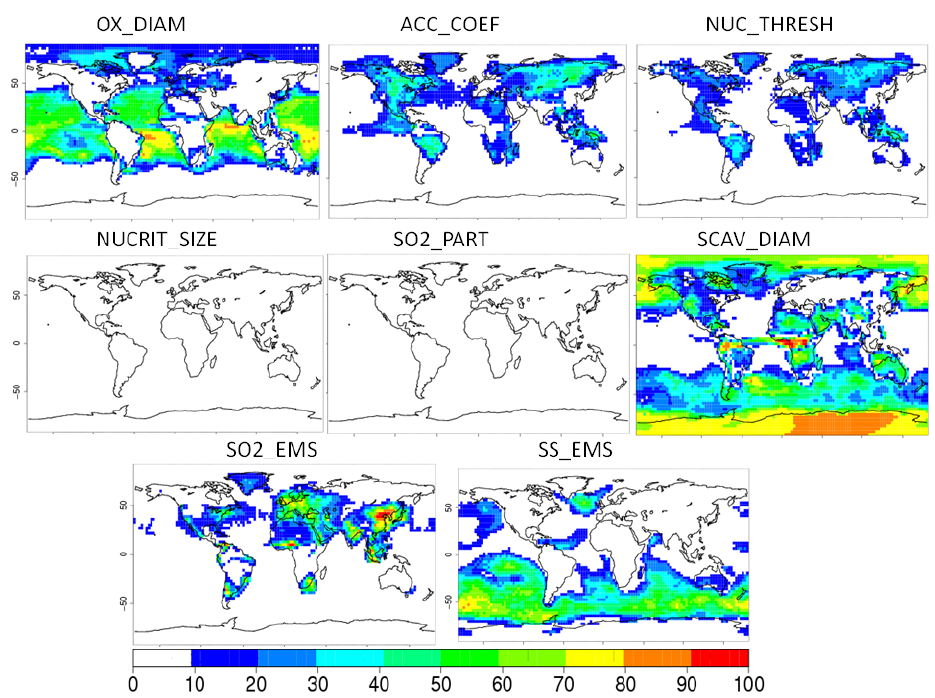
Fig. 4. Percentage of July 2000 CCN variance due to uncertainty in each of the 8 parameters in Table 1 – the main effect.